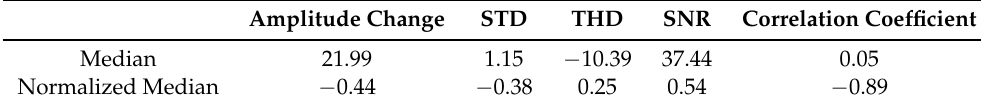
Figure 17. The electro-resistive band (ERB) output and expected sine wave showing high phase difference and low correlation coefficient. Table 5. The median and normalized median for all